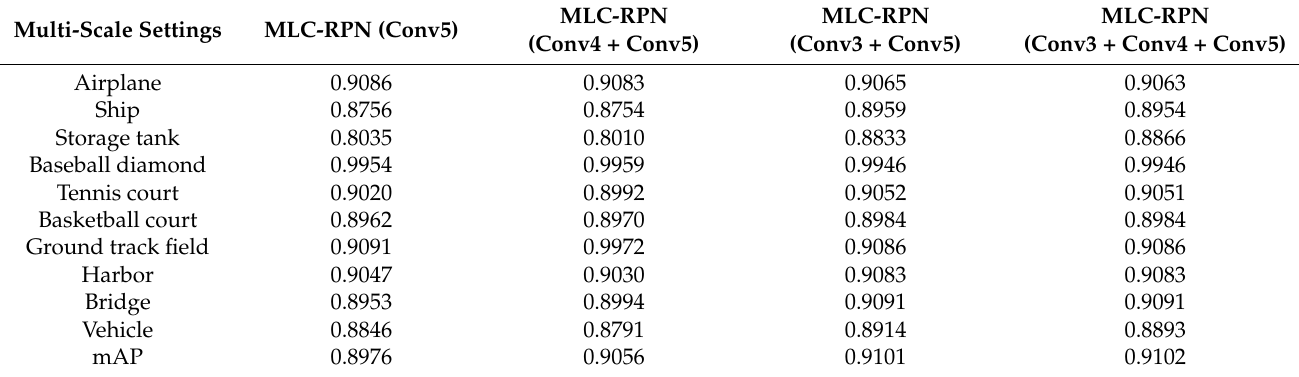
Table 5. Comparison of different multi-scale features utilized in the MLC-RPN. (The evaluation metric: AP; Dataset: NWPU-VHR (train:20%, val:20%, test:60%)). Multi-Scale